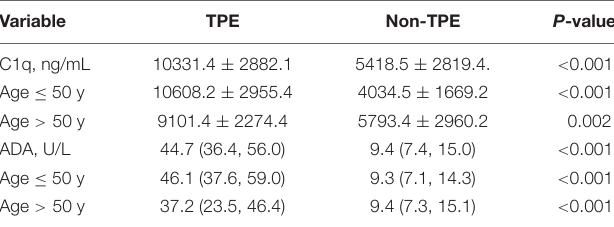
TABLE 2 | Concentrations of C1q and ADA in PF according to